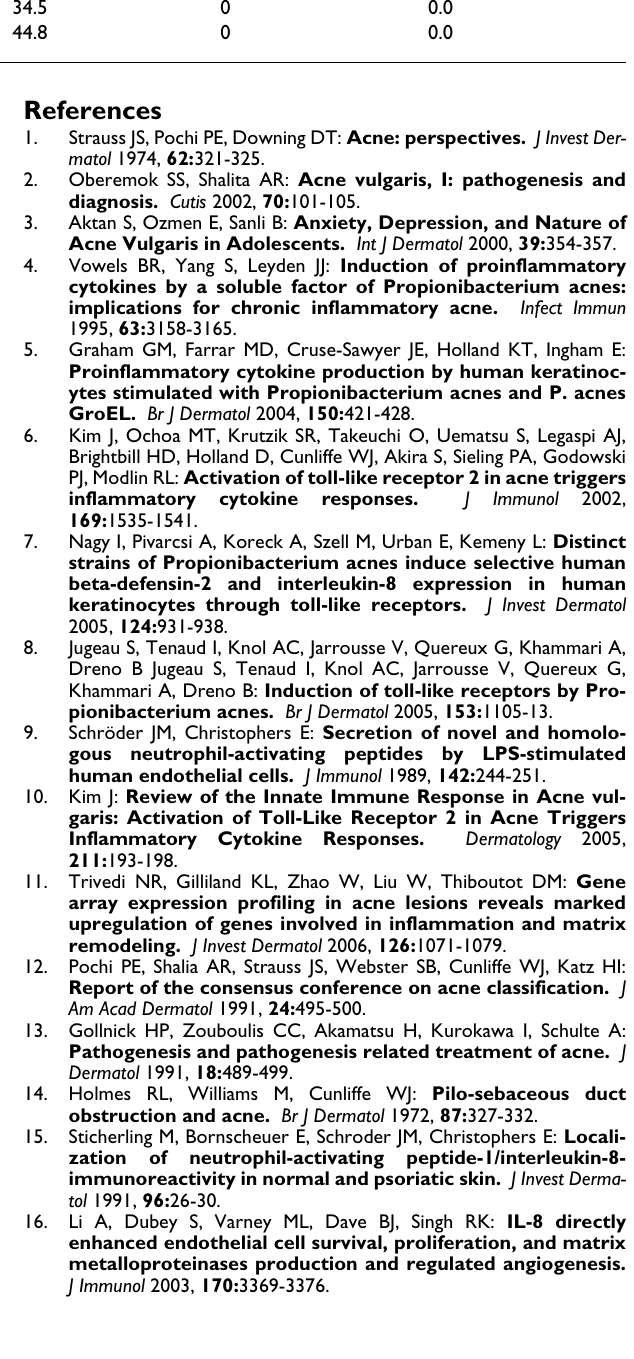
Dermal P < 0.001 Absent